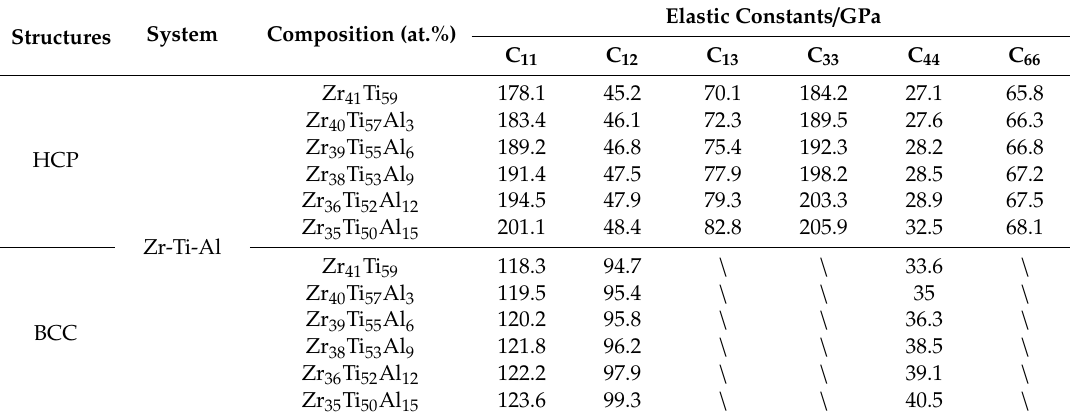
Table 7. Independent elastic constants of HCP structure and BCC structure Zr-Ti-Al alloy systems. Structures System Composition (at.%)